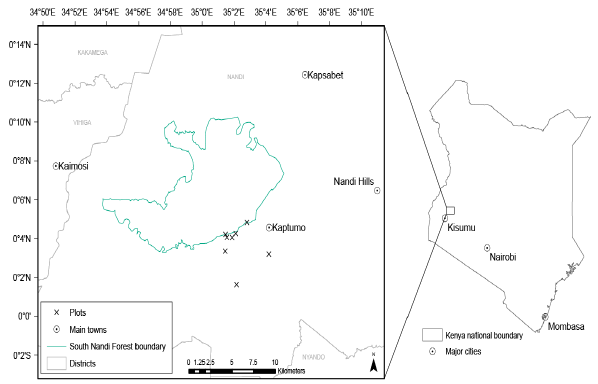
Fig. 1. Map of Kenya showing the study area and the study plots near Kaptumo, Nandi District.